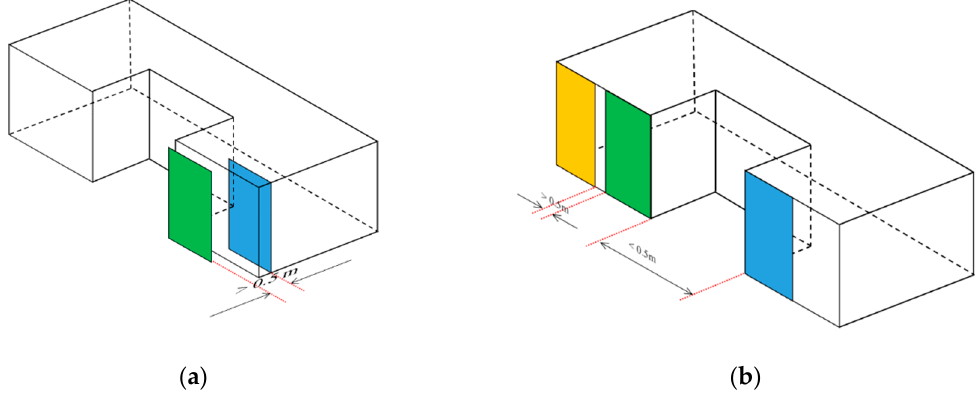
Figure 2. Examples of how to associate segments: ( a ) Perpendicular distance; ( b ) Close segments on the same plane. Different colors are assigned randomly to the different segments.